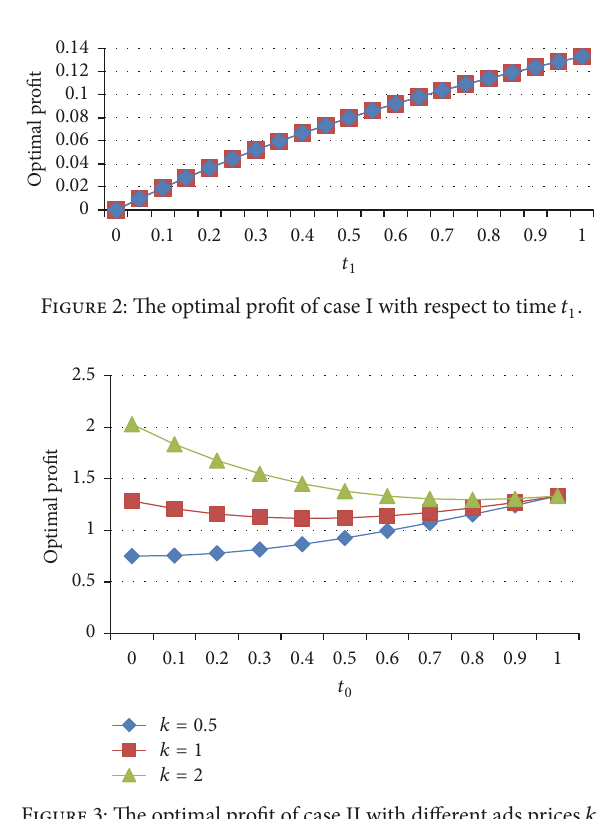
Figure 3: The optimal profit of case II with different ads prices 𝑘